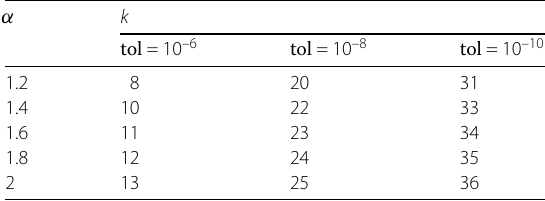
Table 3 INVERSE-FREE iterative Algorithm 4.1 α k tol = 10 –6 tol = 10 –8 tol = 10